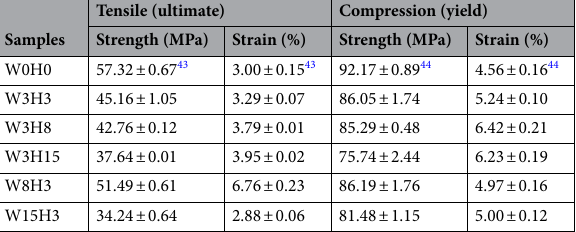
Table 2. Tensile and compression properties of the PLA/WS/HA composites.